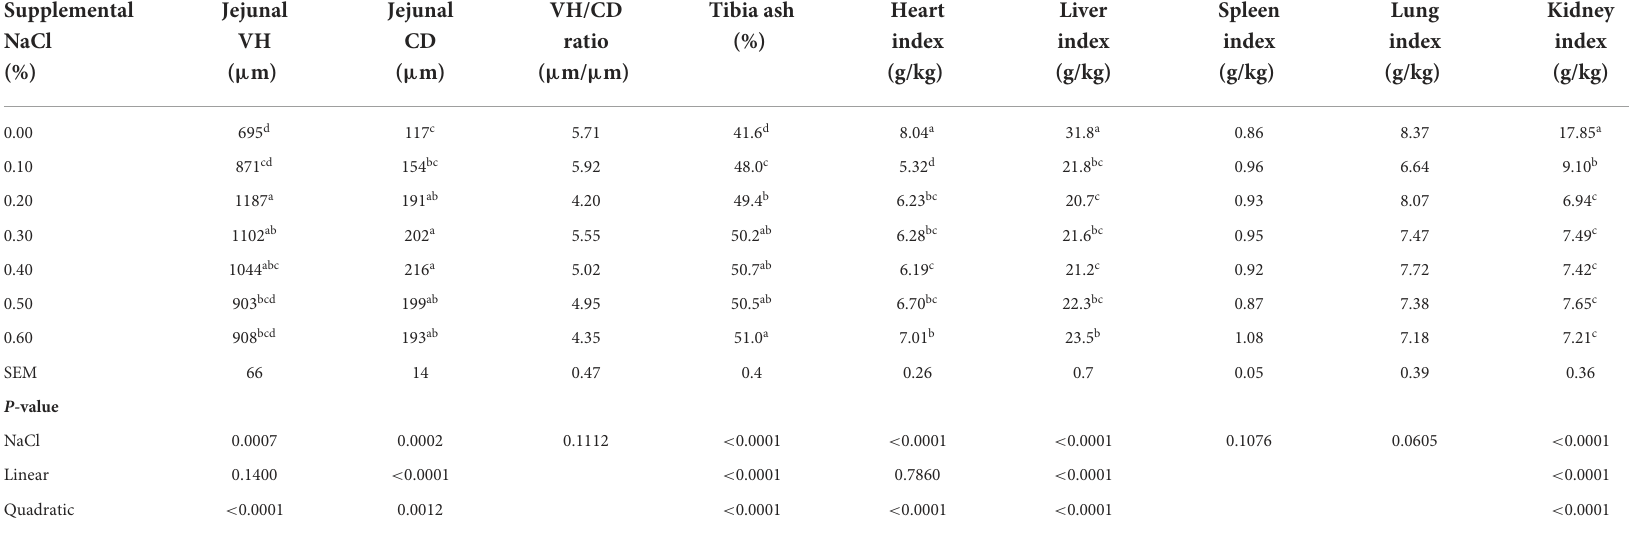
TABLE 6 Effect of dietary NaCl supplemental level on jejunal VH, CD, VH/CD, tibia ash content and organ indices of broilers on day 21 1